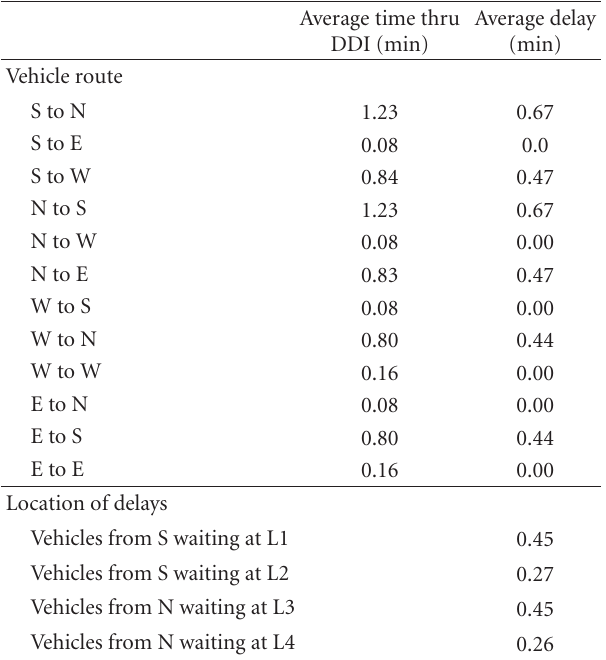
Table 3: Results for Baseline Run1.